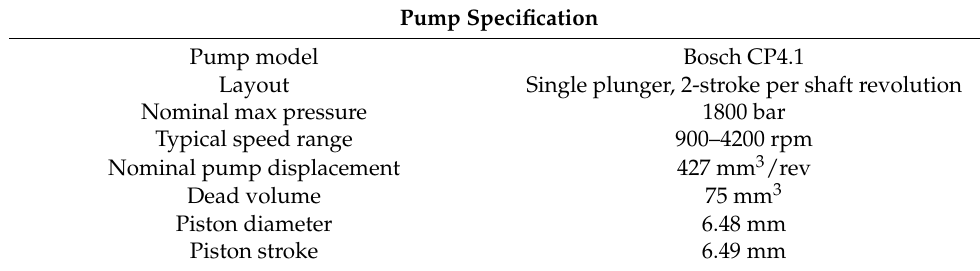
Table 1. Injection pump